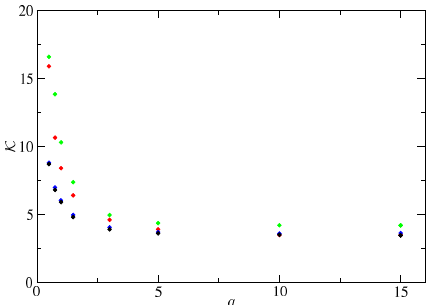
Figure 21. Dependence of K as a function q for the profiles in Equation (82) (red), Equation (83) with λ = 0 (black), Equation (83) with λ = 1 (blue), and Equation (86) (green). The parameters used for the profile C tt ( r ) are q 2 = 3, r j = 2 r m 1 , C tt ( peak,2 ) = 0.3, and δ 2 , obtained from Equation (88) using the previous values with and q 1 = q